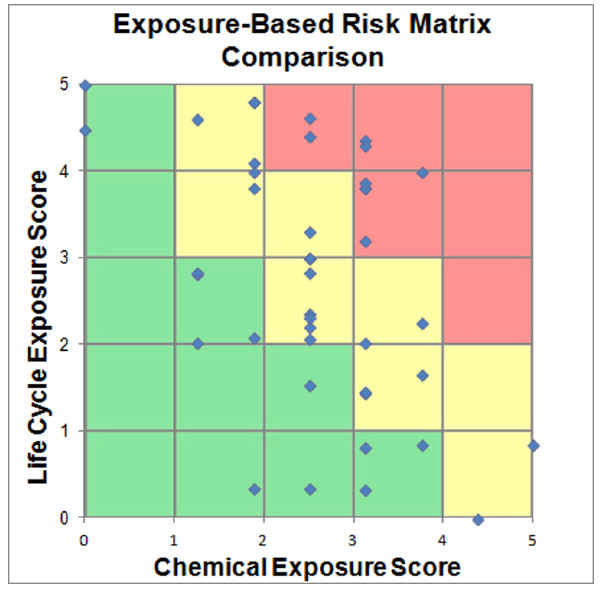
Figure 2. Example Chemical Exposure Potential Risk Matrix.